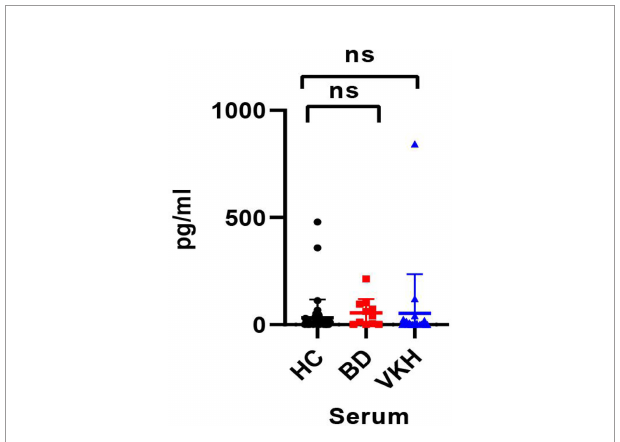
FIGURE 3 | The concentration of IL-35 in serum of the healthy control group and patients with BD or VKH (ns, p > 0.05).